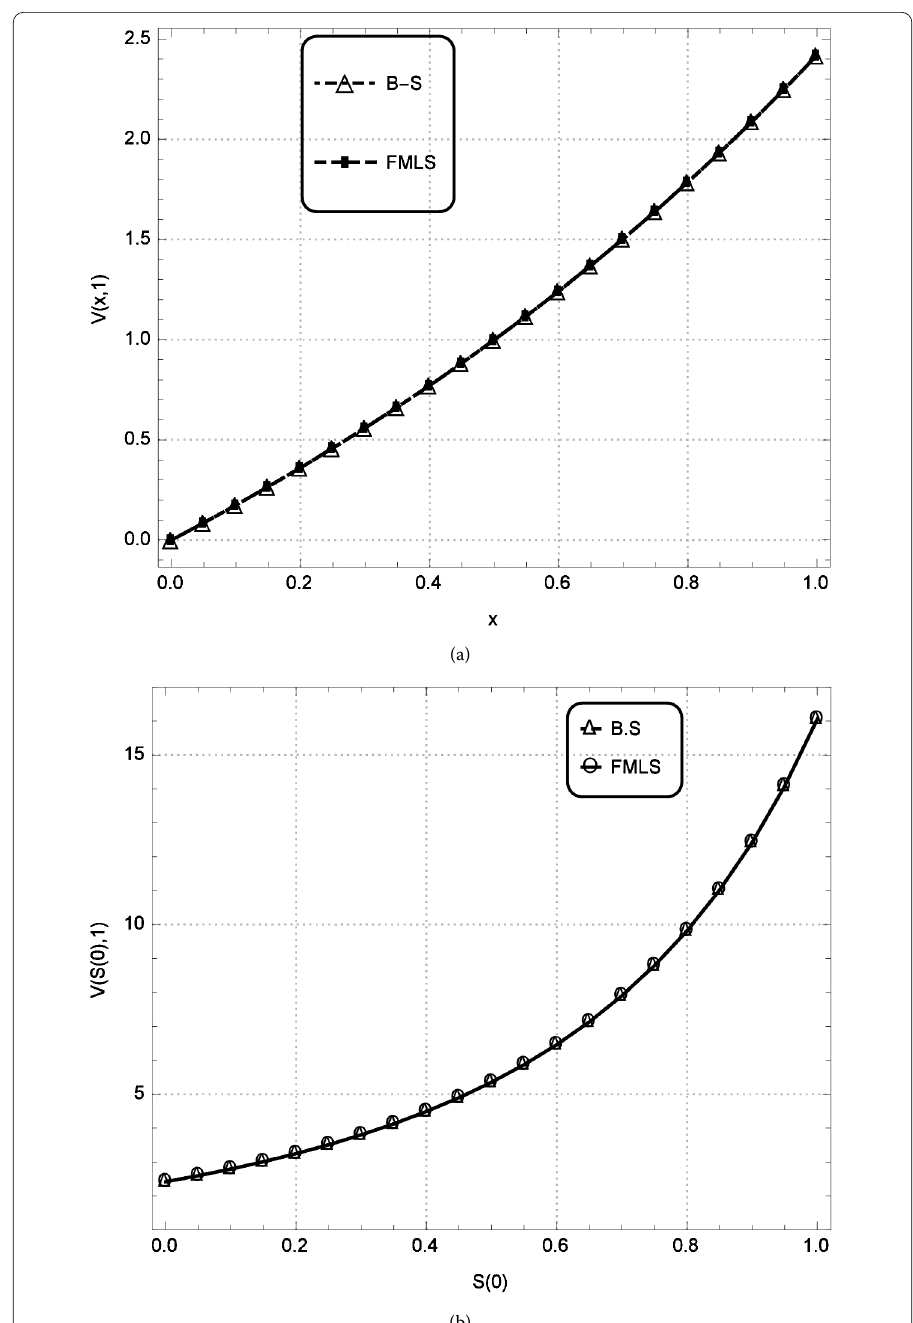
Figure 4 European call options of BS and FMLS models at γ = 2, t =